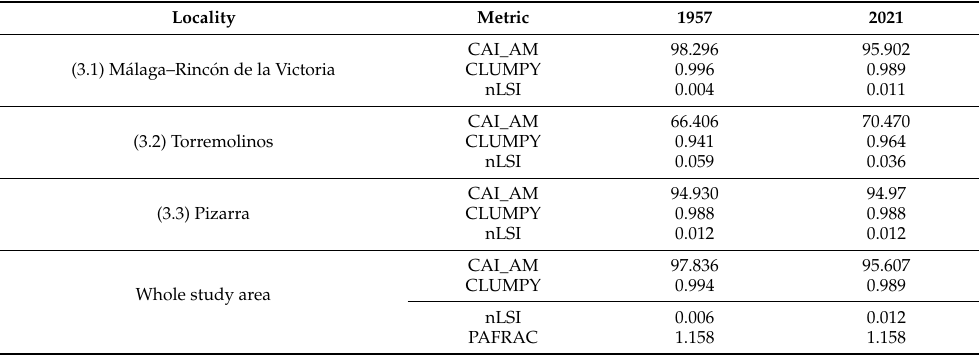
Table 3. Habitat fragmentation metrics during 1957 and 2021 in the study area. Clumpiness Index (CLUMPY), Normalized Landscape Shape Index (nLSI), Area Weighted Mean Core Area Index (CAI_AM), and Perimeter-Area Fractal Dimension